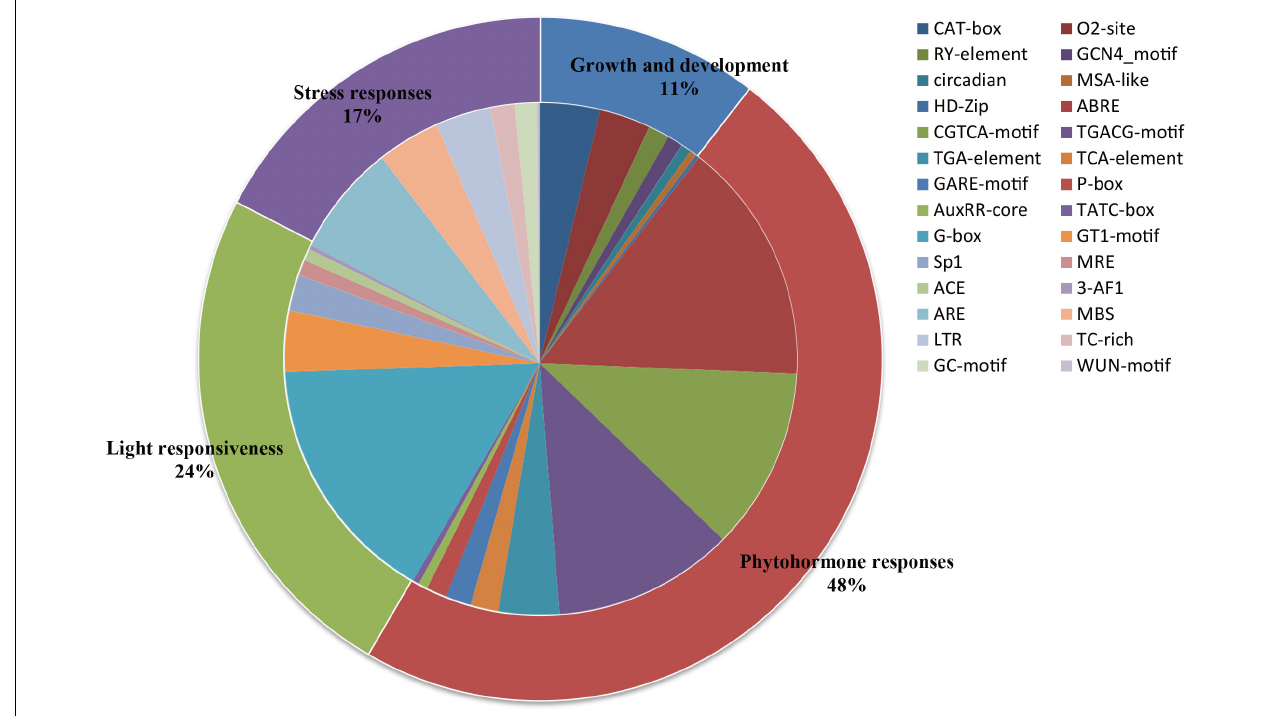
FIGURE 6 | Cis-acting elements of all PLT genes in seven Gramineae crops. The ratios of primary categories/cis-elements are displayed by different sizes in the pie